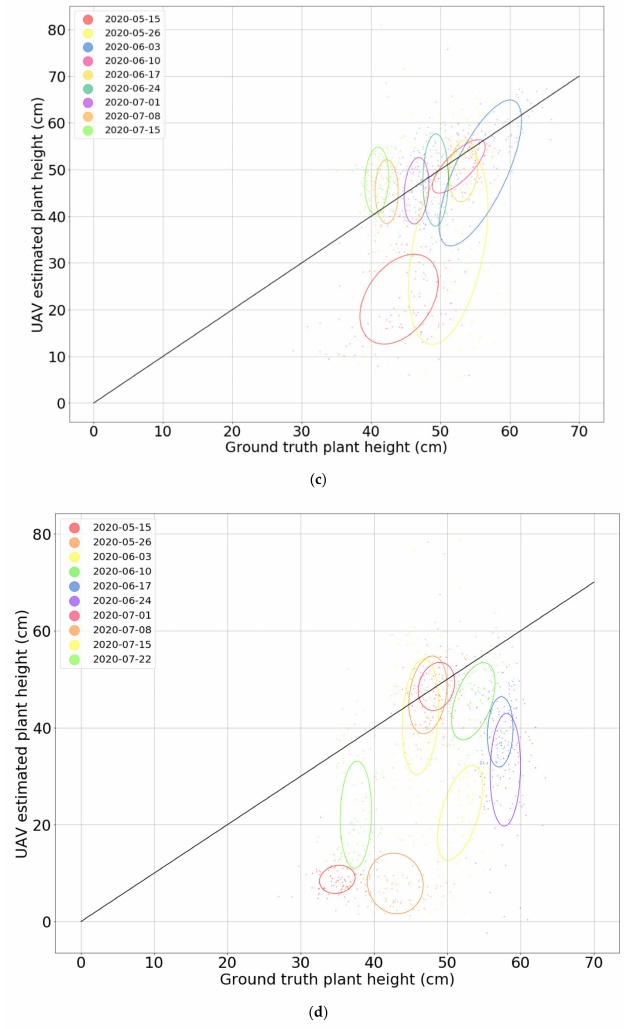
Figure 7. Scatter plots of the UAV-estimated plant height compared with the ground-truth plant height for ( a ) cabbage, ( b ) pumpkin, ( c ) barley, and ( d ) wheat. The plots include the 95% confidence ellipses of the covariance matrices per